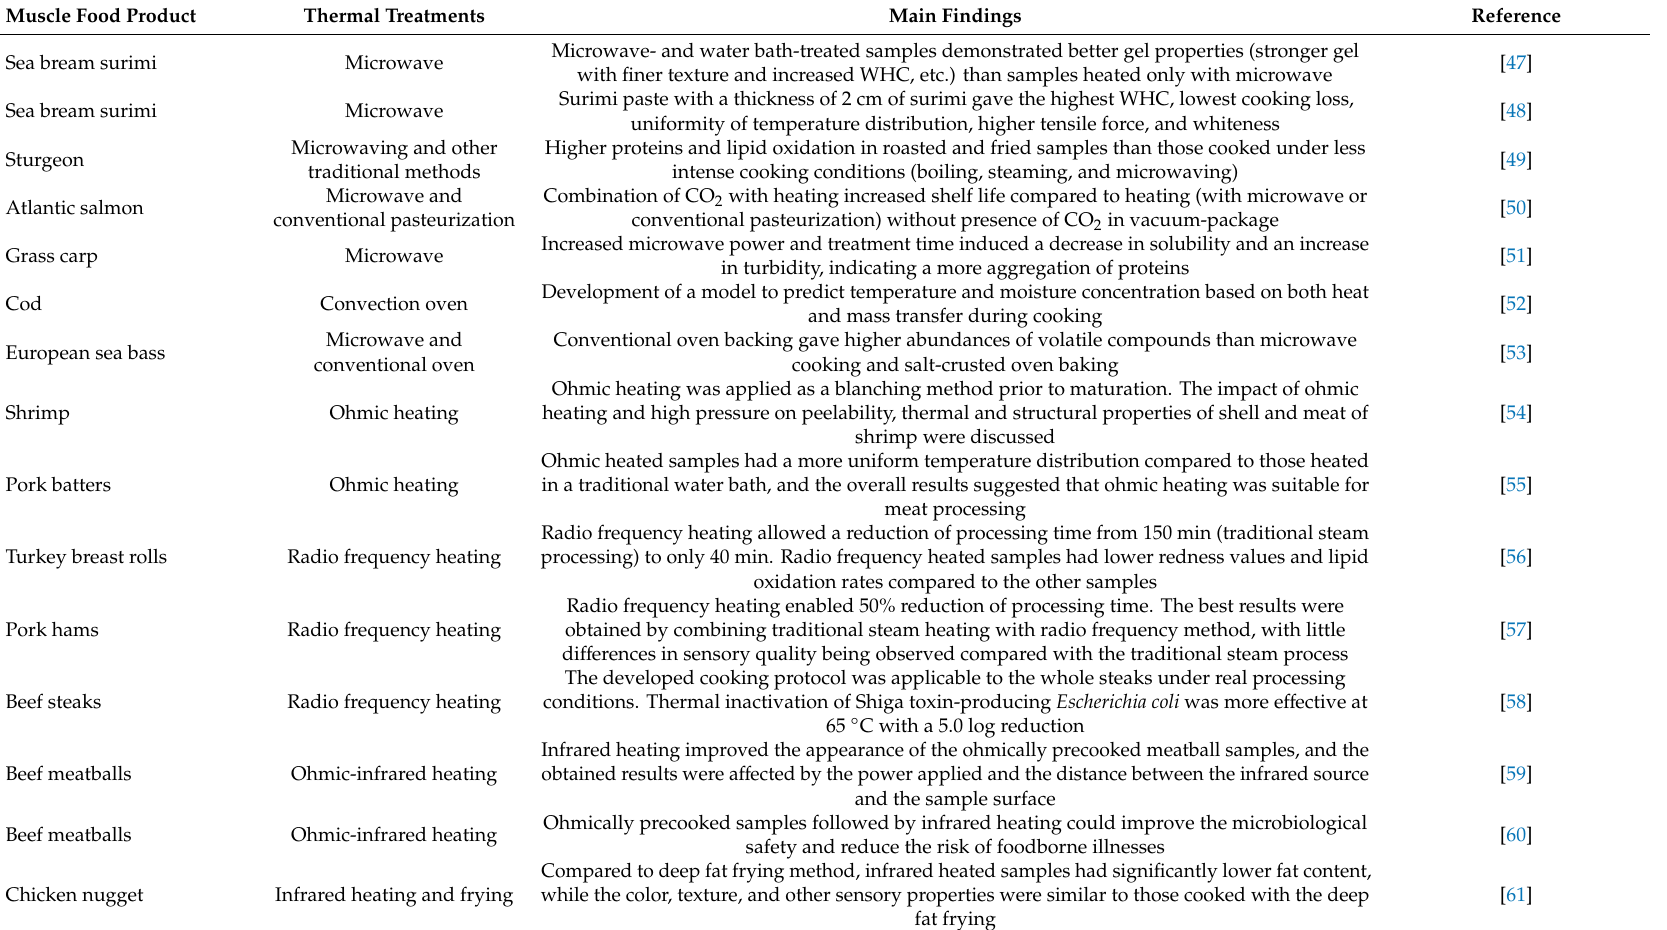
Table 1. Some examples of thermal technologies applied for muscle food